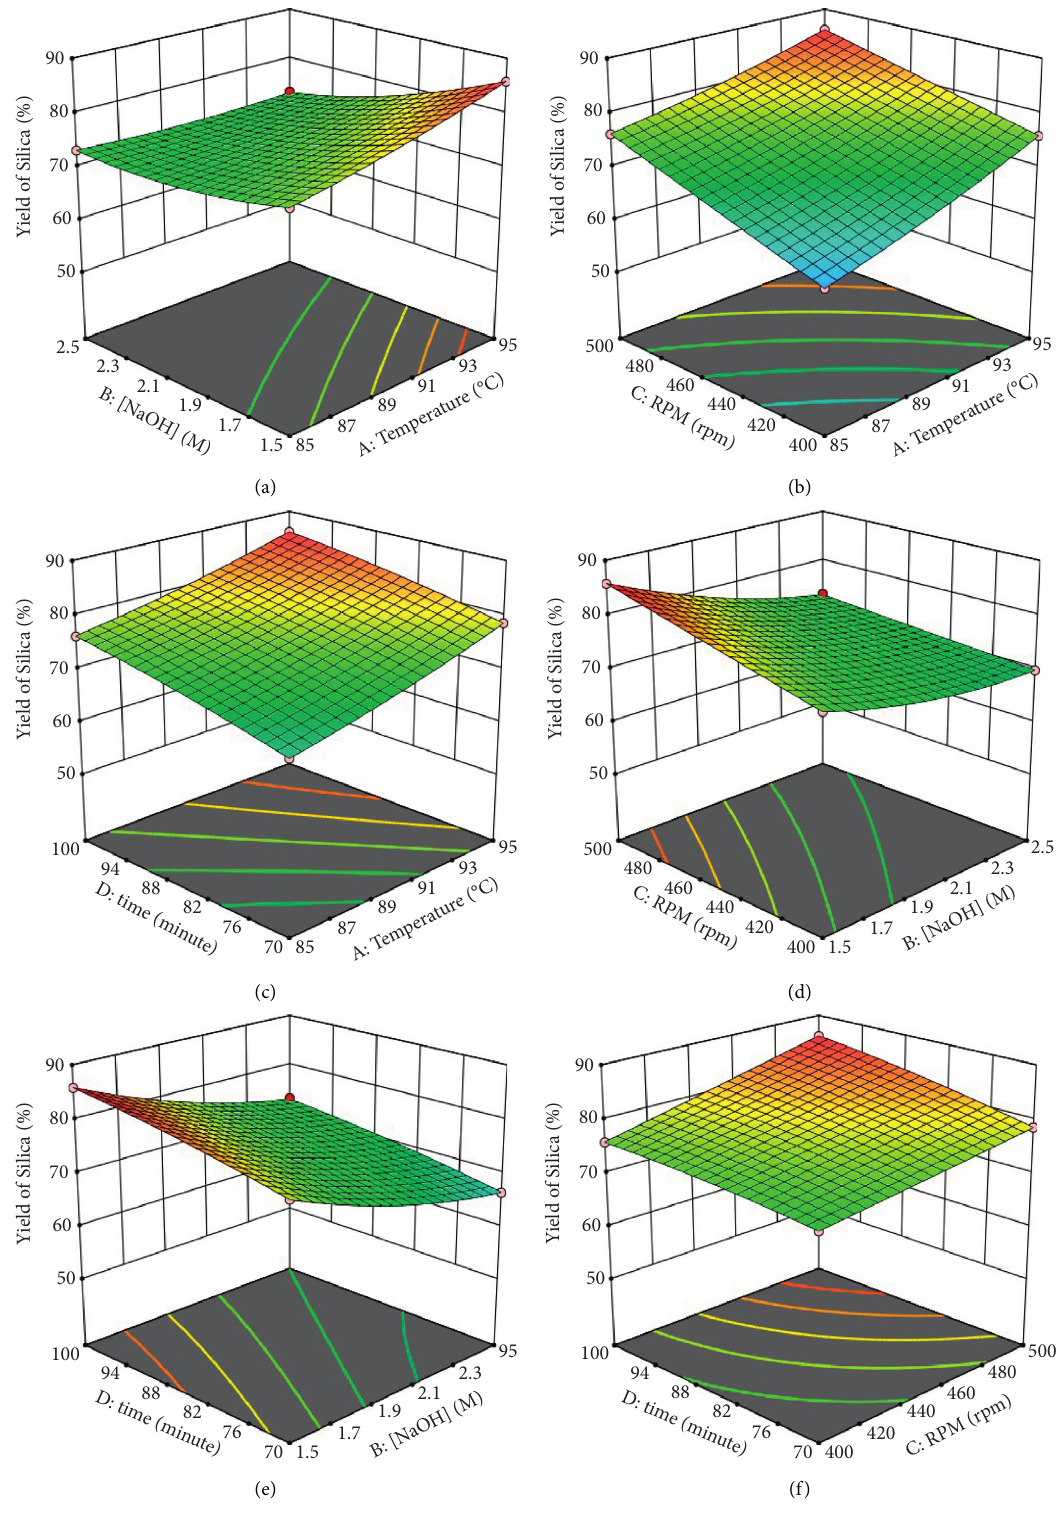
Figure 5: 3D interactive surface plot for biosilica yield: (a) NaOH and temperature, (b) rpm and temperature, (c) time and temperature, (d) NaOH and rpm, (e) NaOH and time, and (f) time and